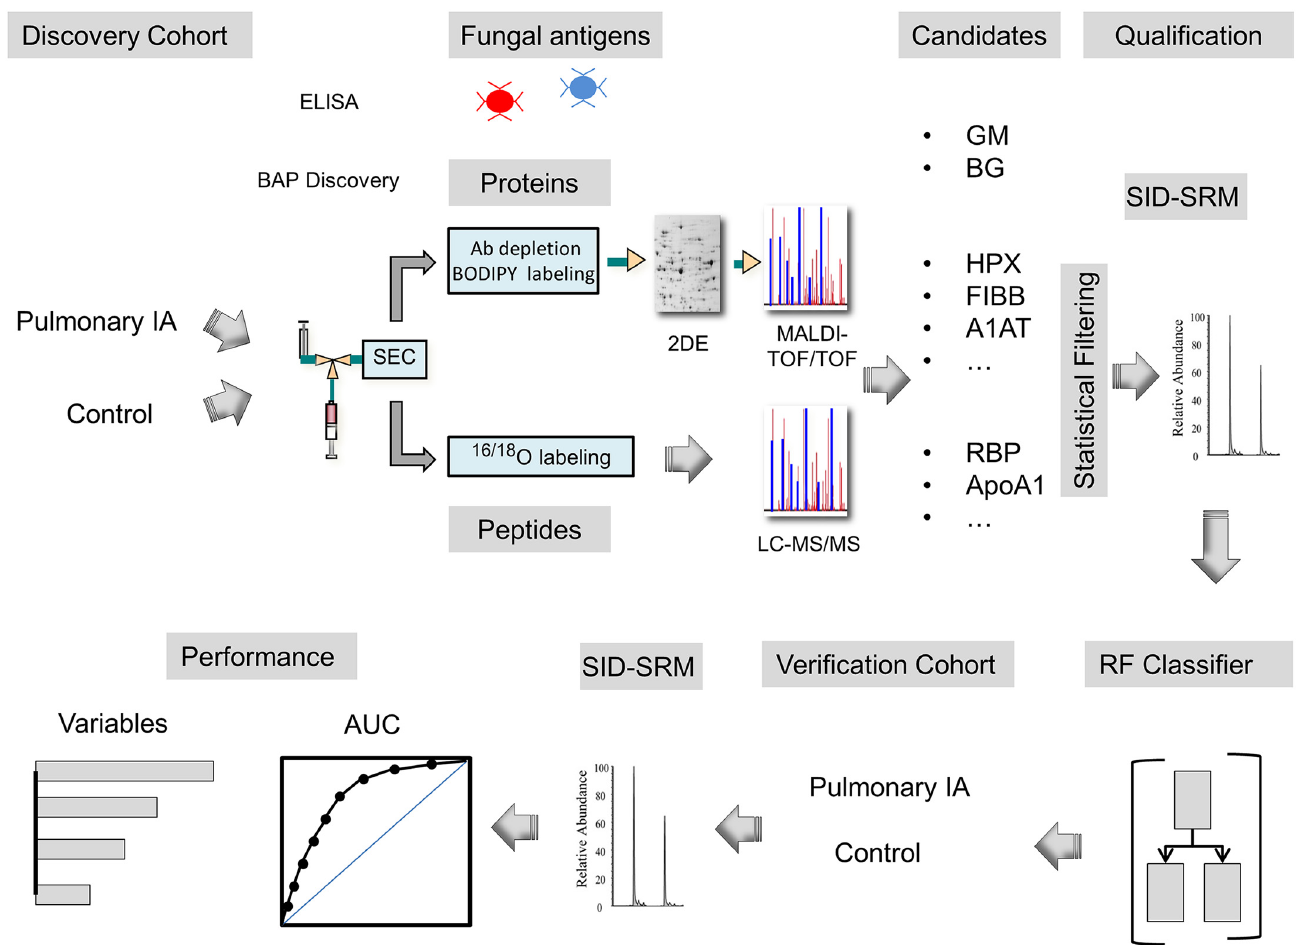
Fig 1. Schematic view of panel development for pulmonary IPA. Schematic view of strategy for discovery, qualification, and verification of panel-based classifiers. The BAP fractionation platform fractionates proteins and peptides for analysis by automated size exclusion chromatography (SEC). Candidate biomarkers were assembled based on proteins identified in the discovery phase and by previous studies. For each candidate, targeted proteomics assays using stable isotope dilution (SID)-selected reaction monitoring (SRM) assays were developed, standardized, and used to quantitate the abundance of the candidate biomarker in the discovery population (qualification). Nonparametric statistical filters were used to identify 15 host response proteins/peptides and 2 fungal polysaccharides. SID-SRM-MS measurement of host-response proteins and peptides were used to test RF classifier